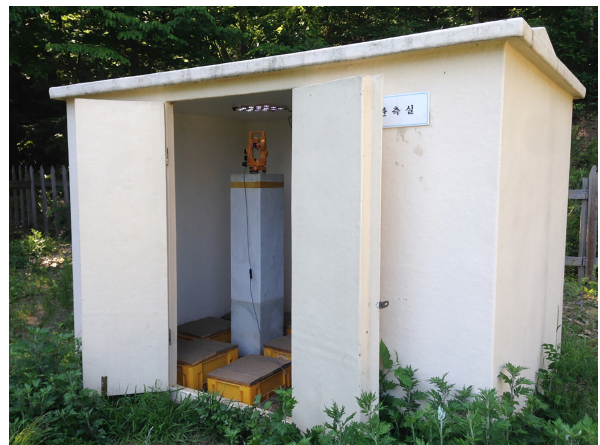
Figure 3. LED light panels installed in the absolute-measurement